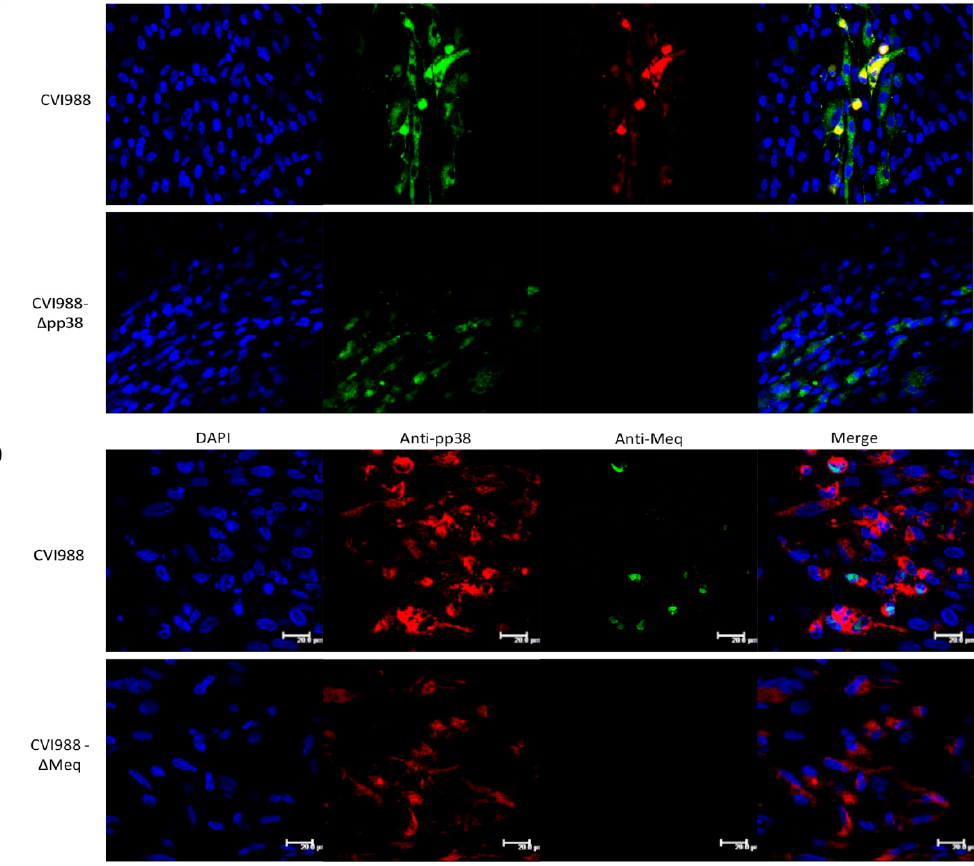
Figure 3. Confirmation of the mutant viruses by IFA. ( a ) Confirmation of pp38 gene deletion in infected CEF by IFA with anti- pp38 monoclonal antibody BD1 (red), anti-gB monoclonal antibody (green) staining was used as infection control. ( b ) Confirmation of Meq gene deletion in infected CEF by IFA with anti- Meq monoclonal antibody FD7 (green), anti- pp38 monoclonal antibody BD1 staining (red) was used as a control (scale bar = 20 µm).